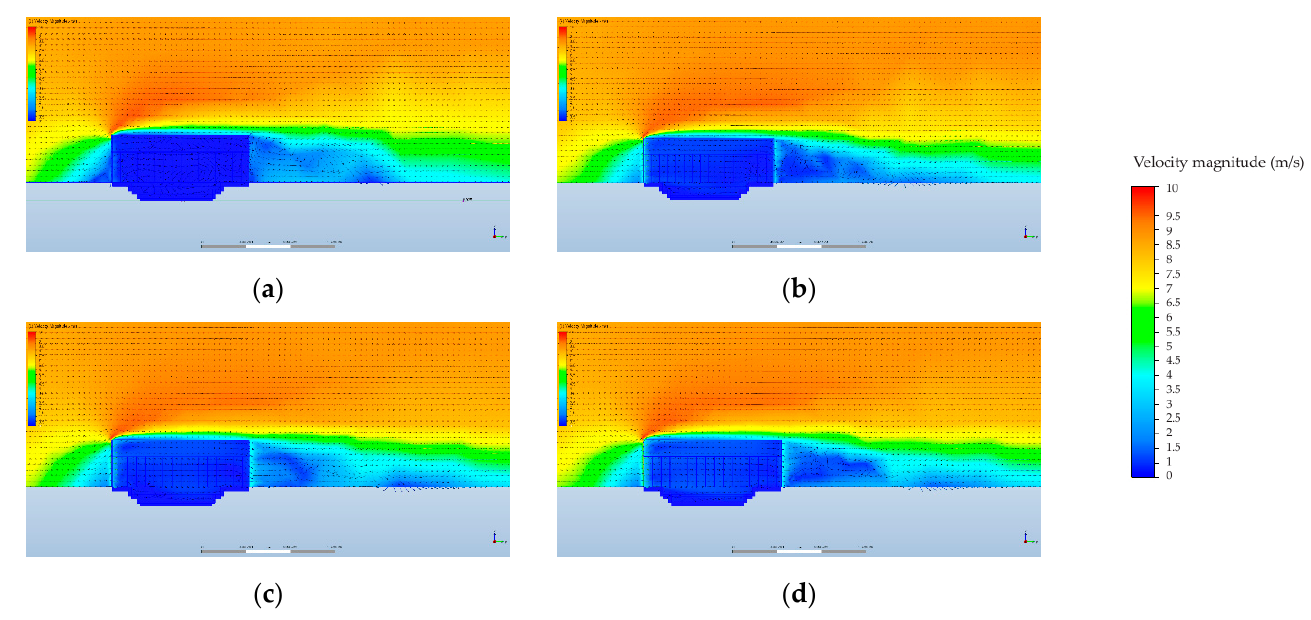
Figure 11. Airflow velocity and direction inside and nearby the plank house, whose smoke hole is closed ( a ) 1 cm gap; ( b ) 2 cm gap; ( c ) 3 cm gap; ( d ) 4 cm gap (Autodesk CFD ® ).